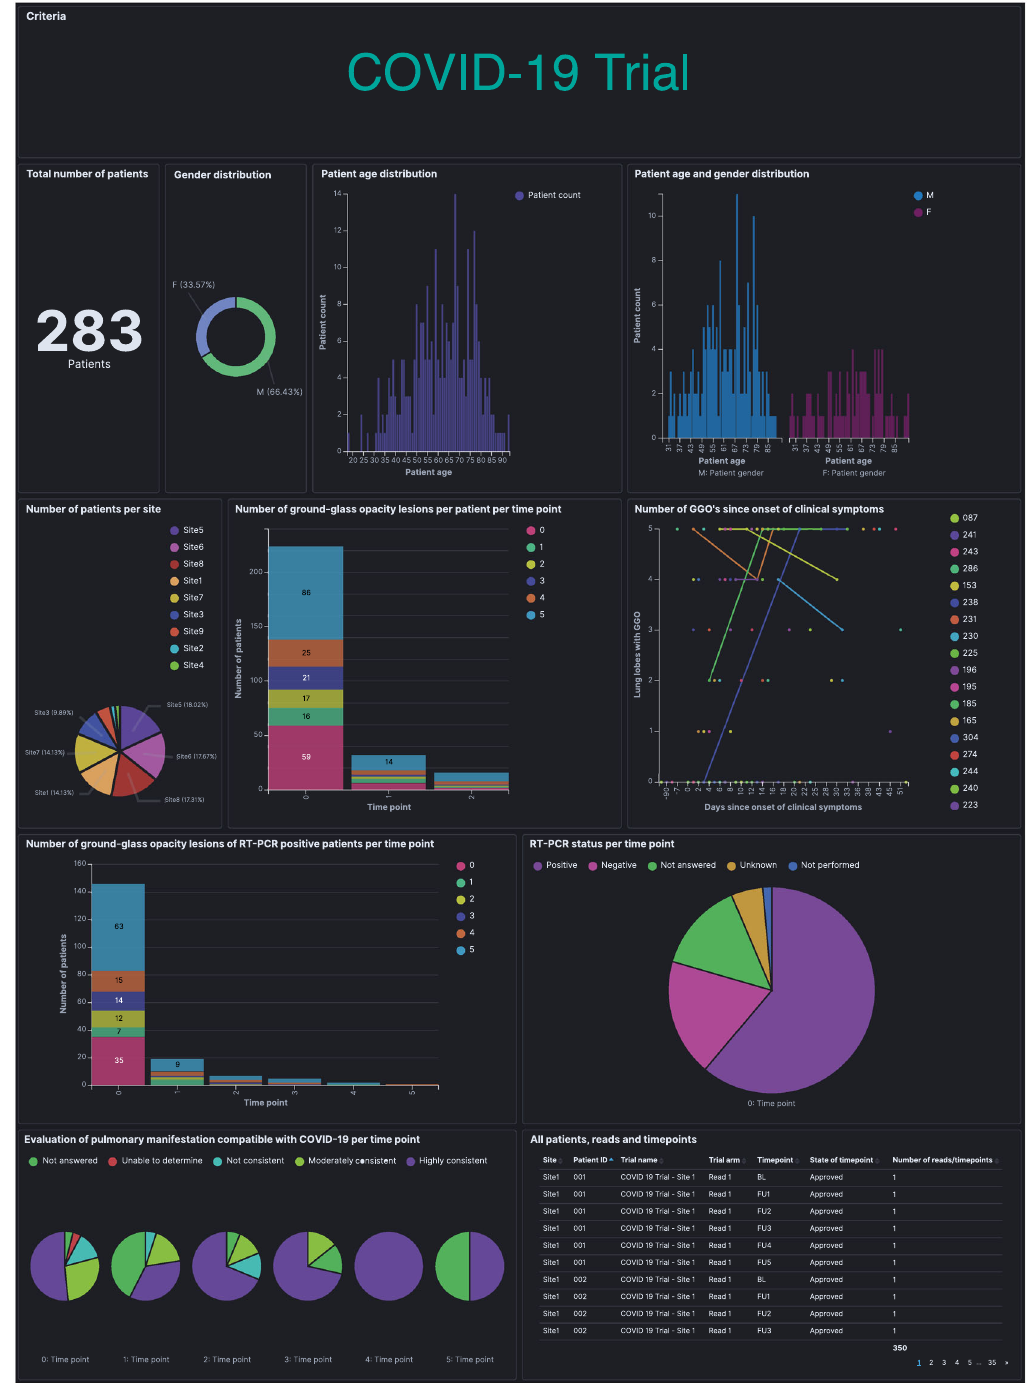
Fig. 3 Multicenter data aggregation in a real-time analytics dashboard. Overview of ad hoc COVID-19 usage analysis, including 283 patients (upper left) from eight European hospitals. The data analysis dashboard is made publicly available on https://covid19.mint-imaging.com (for details see “ Data availability ”